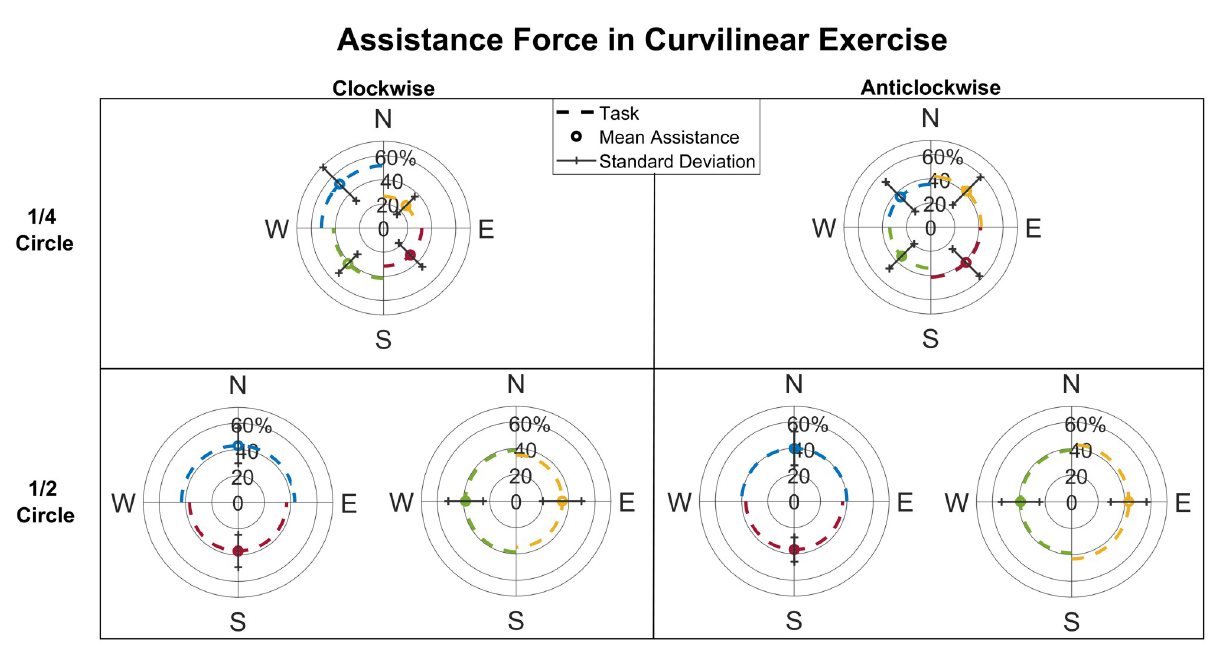
Fig 10. Curvilinear assistance level. Mean inter-subject assistance and deviation in the Curvilinear mode, displayed for ¼ circle and ½ circle and for direction of execution (clockwise and anticlockwise).